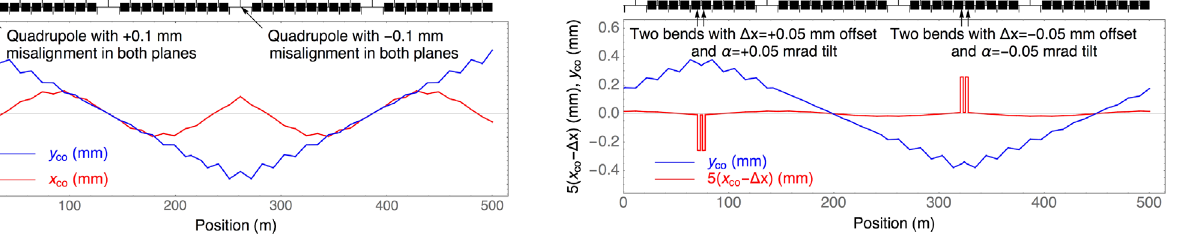
FIG. 6. Vertical and horizontal closed orbit with two pairs of bending elements with a horizontal offset of (cid:3) 50 μ m and a tilt (rotation around the longitudinal axis) of (cid:3) 50 μ